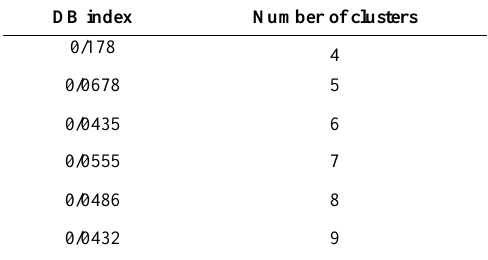
Table 1. Davies-Bouldin index